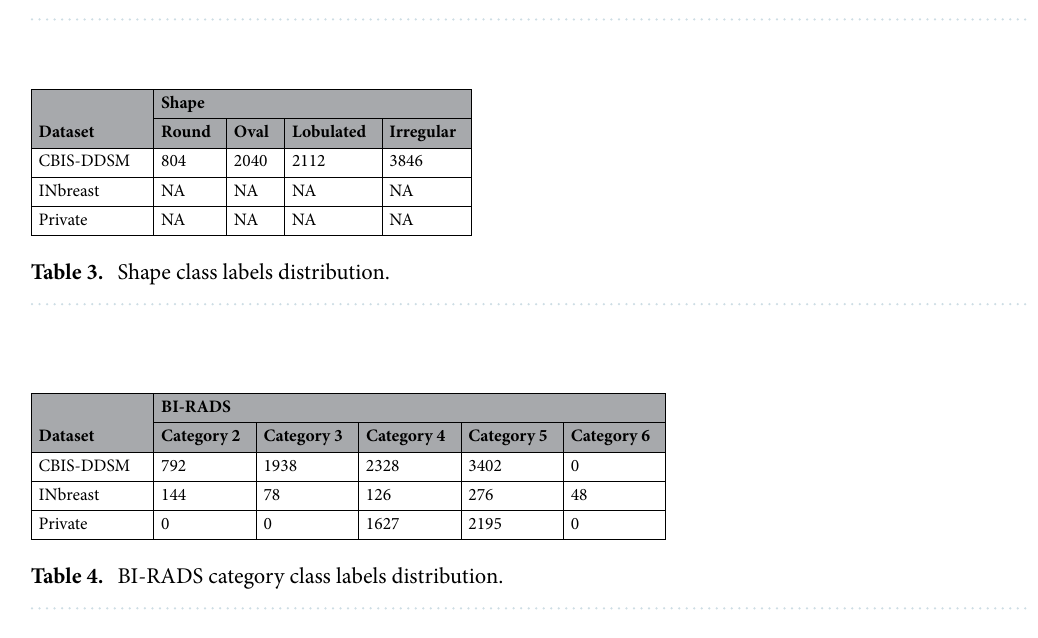
Table 2. Pathology class labels distribution. *Cases with Benign_without_callback are considered Benign. **Cases with BI-RADS score > 3, are considered Malignant otherwise Benign.